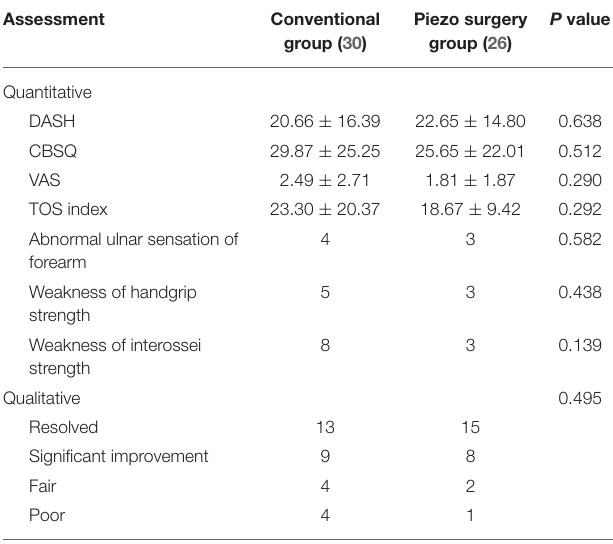
TABLE 2 | Functional outcomes of the conventional group and piezo surgery